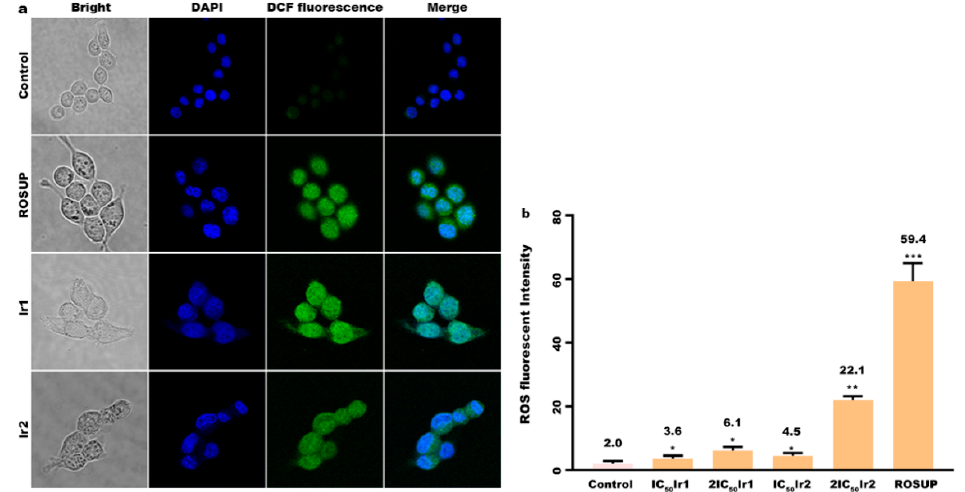
Figure 8. ( a ) Intracellular ROS levels assay after HCT116 cells exposure to ROSUP (positive control) and IC 50 concentration of Ir1 and Ir2 for 24 h. ( b ) DCF fluorescence intensity was determined by flow cytometry after the treatment of HCT116 cells with ROSUP and IC 50 and 2IC 50 concentration of the complexes for 24 h. * p < 0.05, ** p < 0.01, *** p <